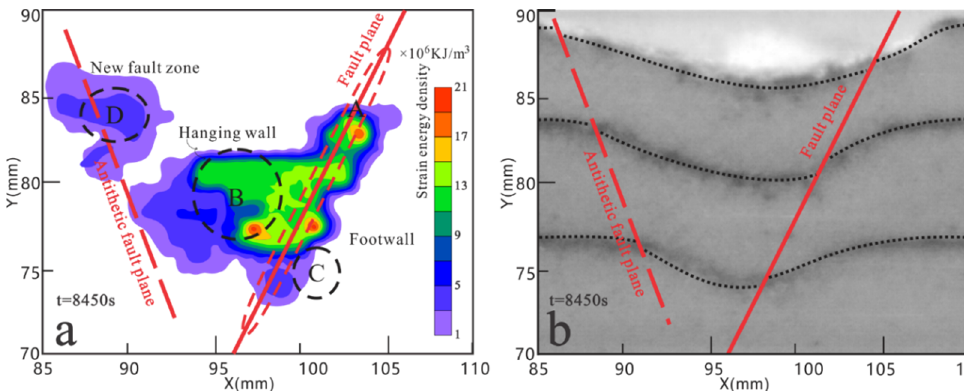
Figure 18. Strain energy density distribution characteristics of different regions. ( a ) The strain energy density distribution mode, A is fault plane zone; B is hanging wall zone; C is footwall zone; D is new fault zone; ( b ) the normal fault from the simulation chamber at t = 8450 s. Table 5. Range conversion table for each region of the normal fault in the prototype and experi- ment (L* = 2 × 10 − 5 ).